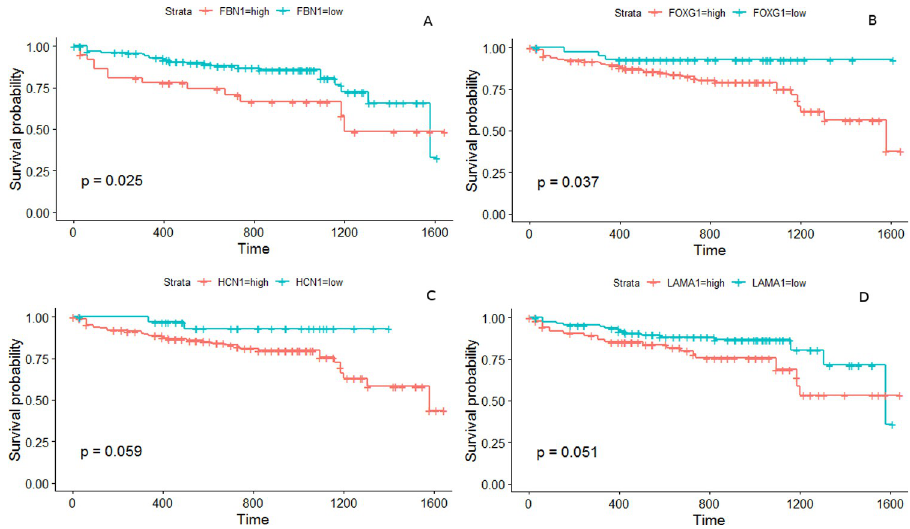
https://doi.org/10.1371/journal.pone.0249151.g009